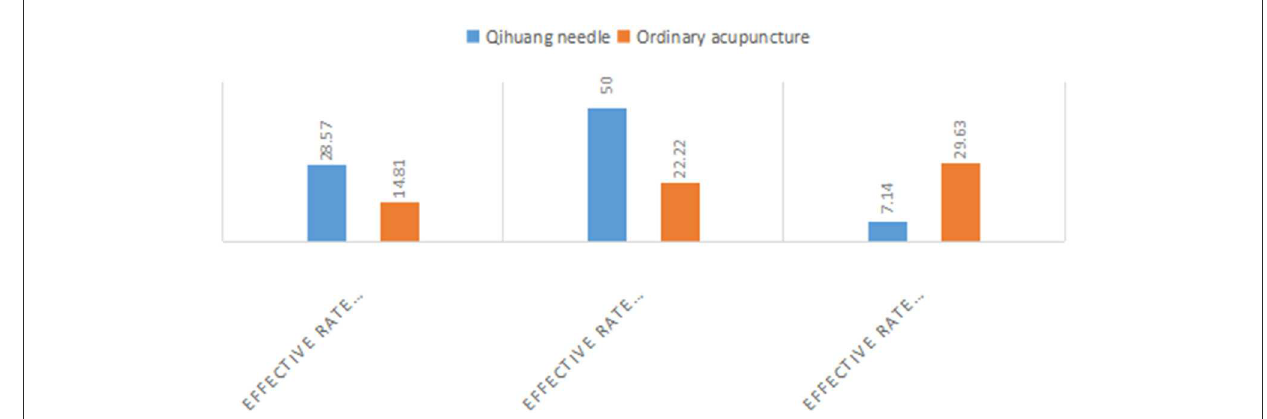
FIGURE2 A bar chart of the ratio of treatment courses between the two groups.